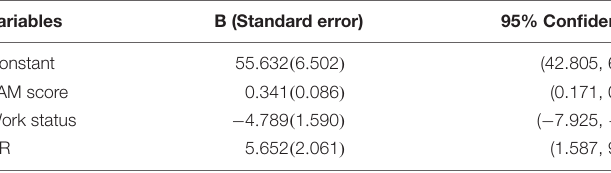
TABLE 4 | Stepwise multiple linear regression model of predictors of